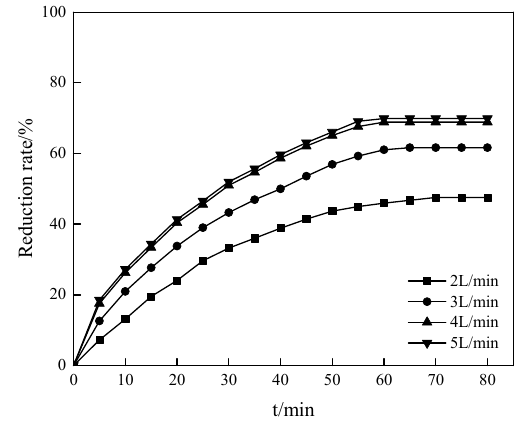
Figure 8. Determination of the reducing gas flow.